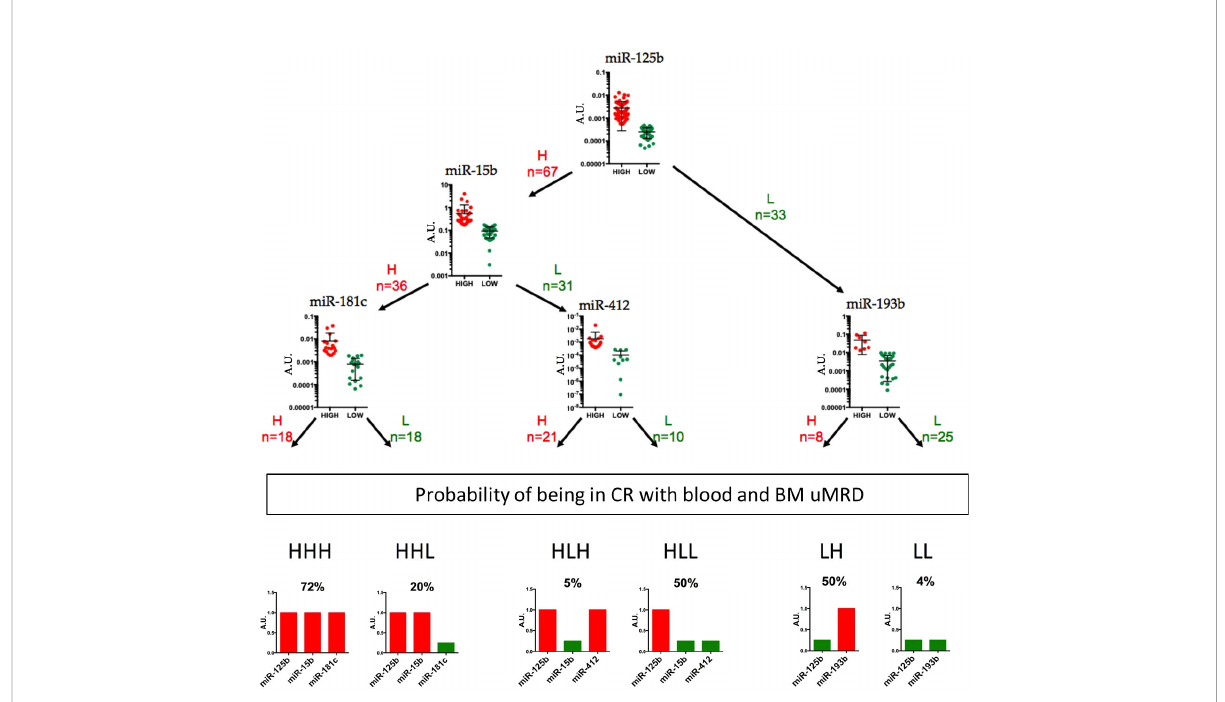
FIGURE 2 A decision-making model using expression of 5 blood miRNAs at baseline to classify B-CLL patients and predict treatment outcome. Receiver Operating Characteristic (ROC) curves method was used to constructed the decision tree, underlying 6 groups of patients. For each group, relative expression of 2 or 3 miRNAs into the blood of B-CLL patients (n=100) can give the probability at diagnosis of being in CR with BM uMRD three months treatment termination. Red and green colors were used for high (H) and low (L) miRNA expression